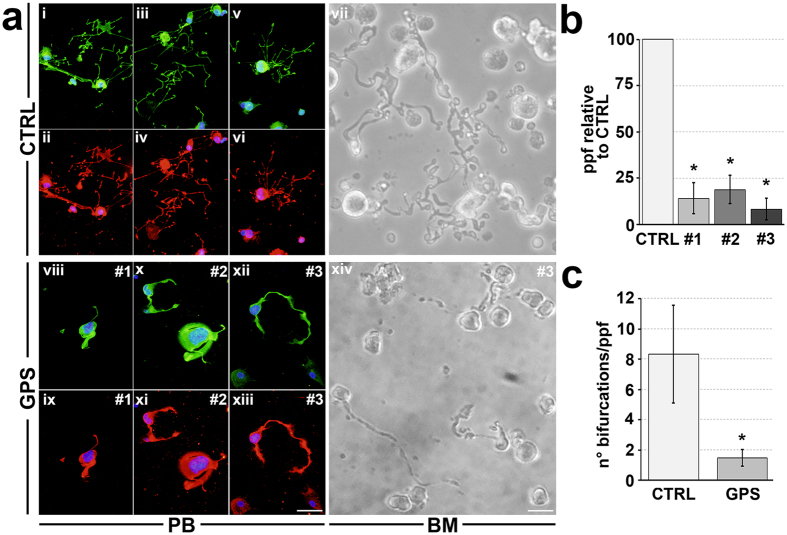
Aberrant proplatelet formation by human megakaryocytes from patients with GPS.(a) Representative analysis of proplatelet formation and structure from control (CTRL)- (i–vii) and GPS-derived megakaryocytes by immunofluorescence (peripheral blood sample i–vi and viii–xiii; green = α-tubulin; red = CD61; blue = nuclei; scale bar = 50 μm) and light microscopy (bone marrow samples vii, xiv; scale bar = 20 μm). Pictures clearly show defective proplatelet elongation in GPS patients. (b) The percentage of proplatelet forming-megakaryocytes (ppf) was calculated as the number of megakaryocytes displaying at least one filamentous pseudopod with respect to total number of round megakaryocytes per analyzed field, and normalized with respect to CTRL. Data are presented as means ± SD (*p < 0.001). (c) Analysis of the number of proplatelet bifurcations per proplatelet forming-megakaryocytes (ppf). Data are presented as mean ± SD (*p < 0.001).